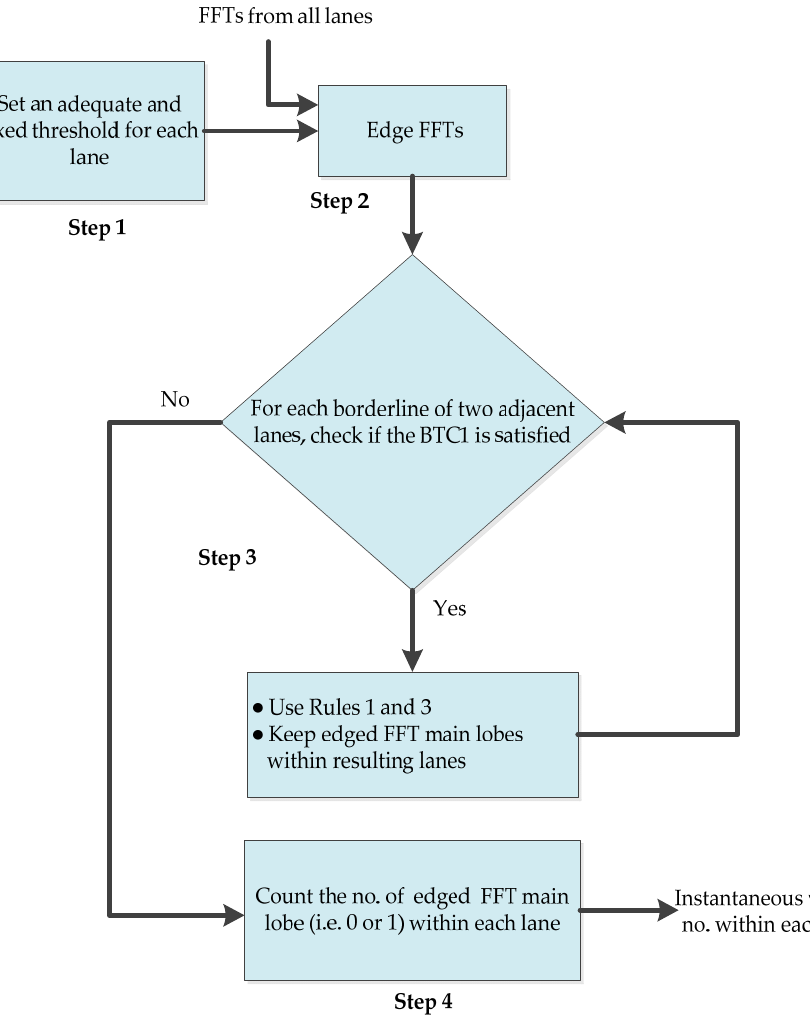
Figure 6. Functional procedure of the proposed method 1.